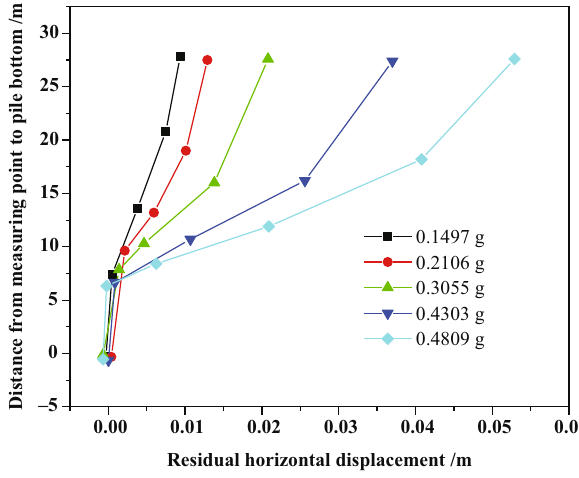
Figure 2: Residual horizontal displacements of P1 pile/M.